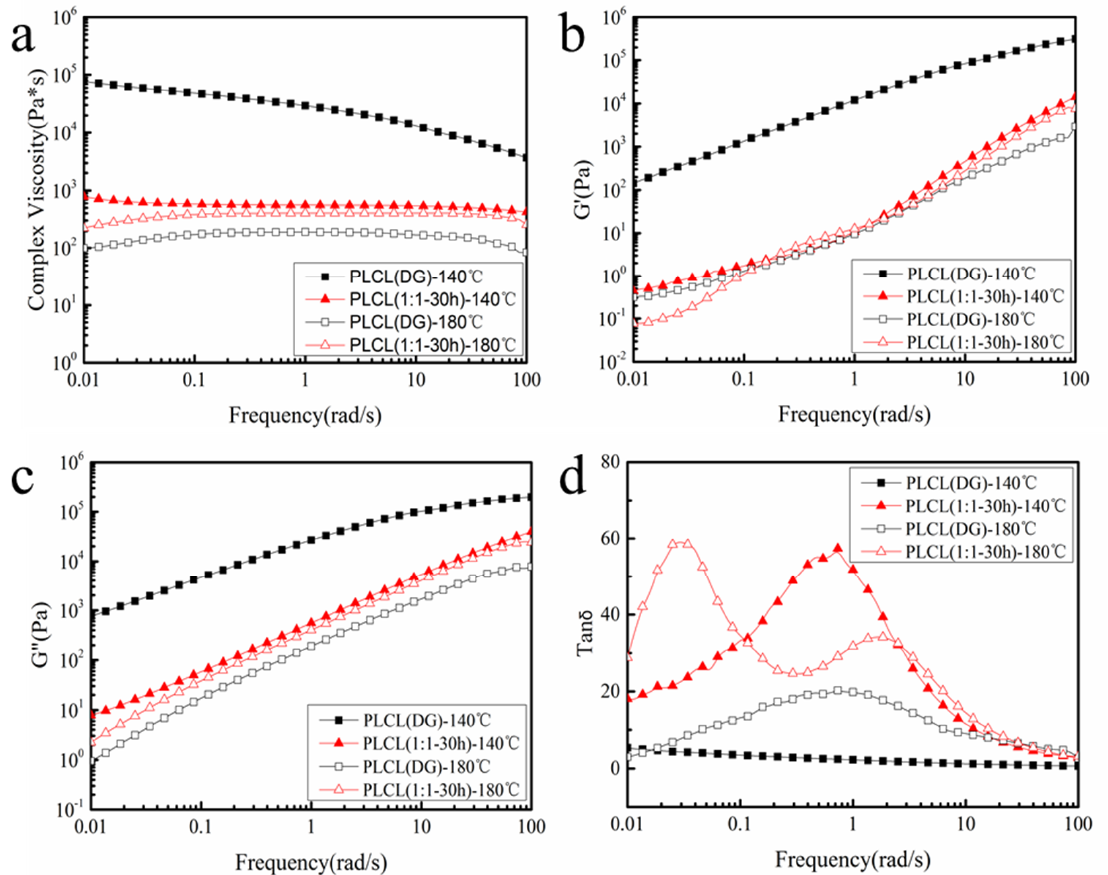
Figure 8. Complex viscosity ( a ), storage modulus ( b ), loss modulus ( c ), and tan δ ( d ) of neat PLCL (DG) and PLCL (1:1-30 h) samples obtained by dynamic frequency sweep at 140 °C and 180 °C.